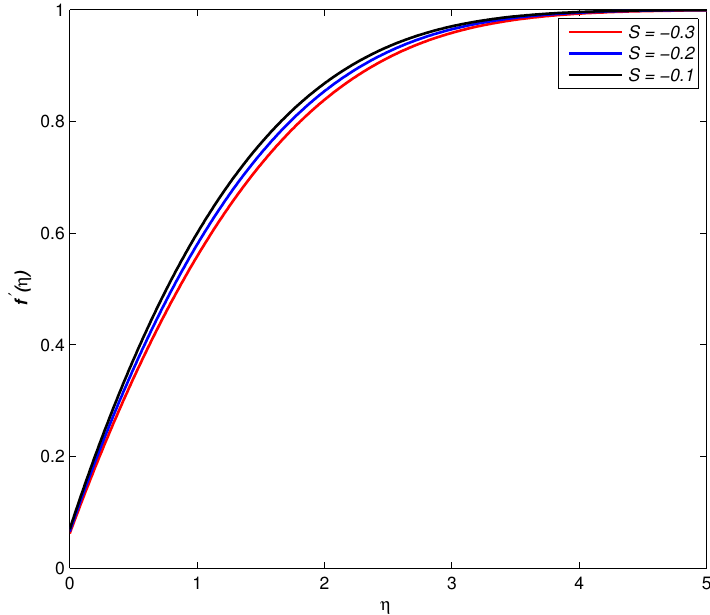
Figure 16. Velocity f (cid:48) ( η ) profiles for different values of blowing parameter S <